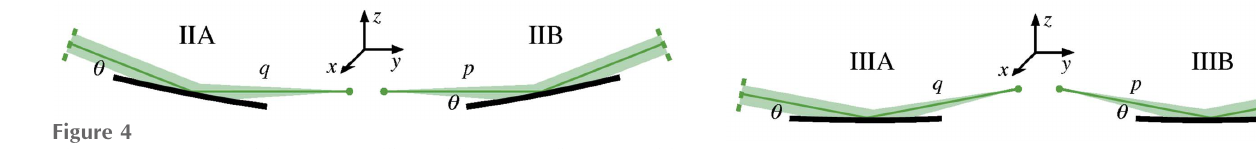
Figure 5 The Type III plane-parabolas are aligned with the surface tangent to the y -axis at the central point of intersection. This is the coordinate system most convenient for fabrication and metrology.